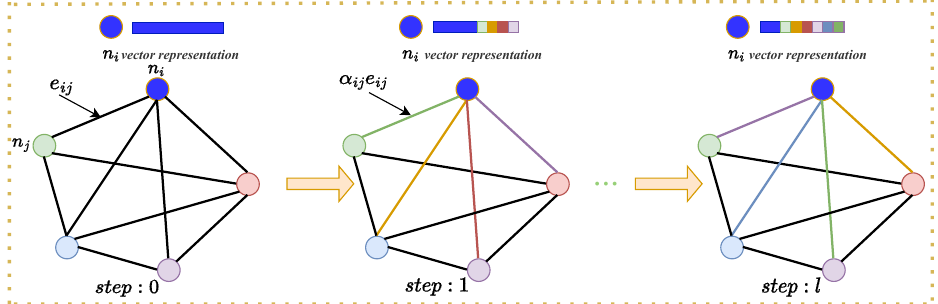
Figure 4. The five nodes in the figure represent the fused visual and haptic features. The line between every two nodes is used as the edge weight. Take vertex n i and vertex n j for example, at step: 0, the edge weight between these two nodes is e ij . The vector of node n i has no information interaction, its feature representation is still original (in blue). At step: 1, the edge weight e ij is added with a new learnable normalisation parameter α ij (the colour of the line from node n i to the another node represents a different normalisation parameter), node n i starts interacting with the other nodes and the weight parameter is updated. Its representation will change to different colours, as shown in the right figure. The cycle continues until the step: l ( l = 50) is